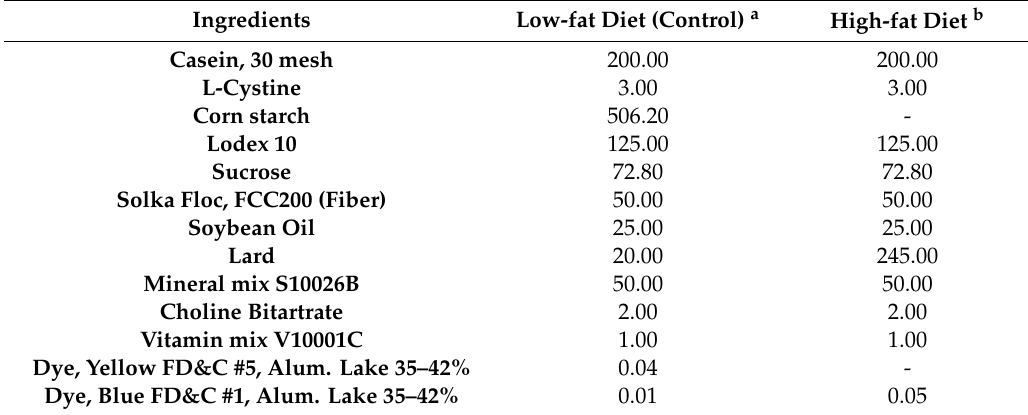
Table 1. An overview of diet composition (g / kg) for both control and high-fat diet-fed